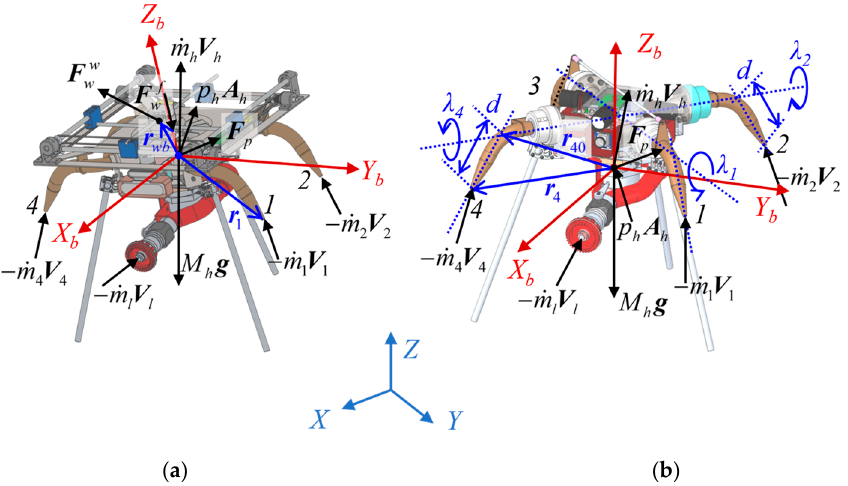
Figure 4. Free body diagram of the head part: ( a ) The weight distribution control system; ( b ) The nozzle rotation control system.